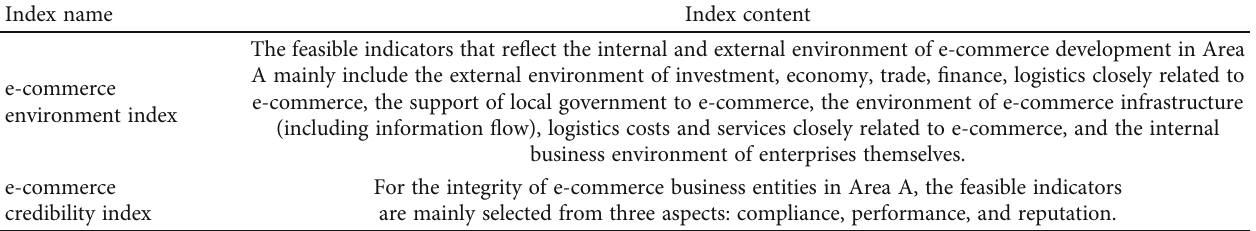
Table 3: Names and contents of digital industry progress index A subindex.